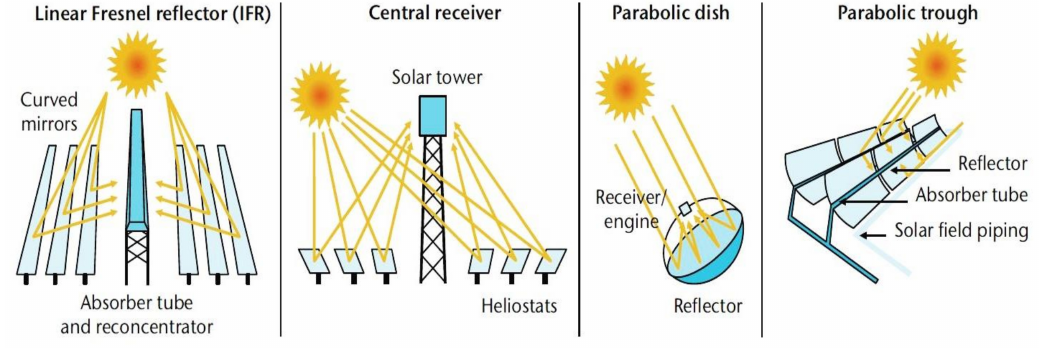
Figure 5. Main CSP technologies [53].